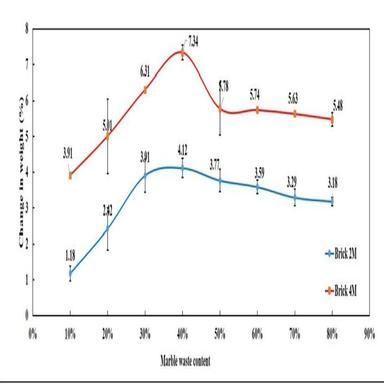
Water loss percentage of hybrid geopolymeric composite samples prepared at different molarities and marble waste content.